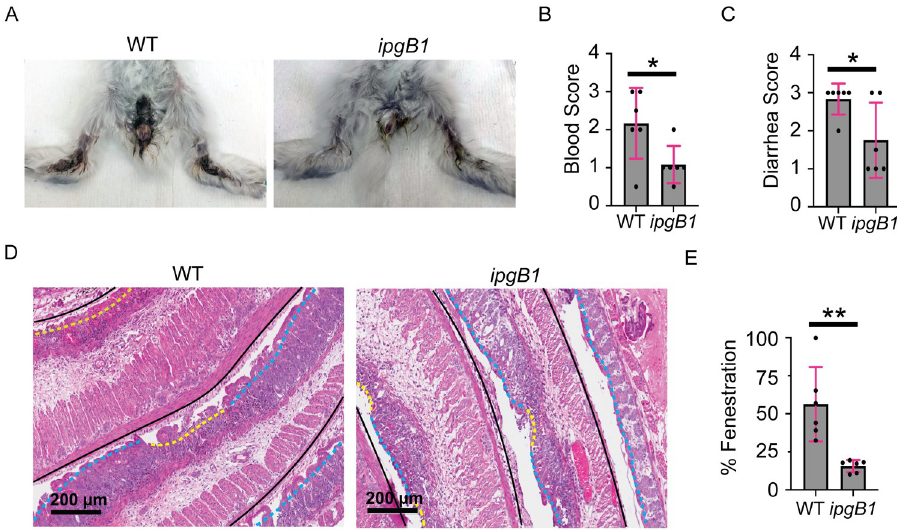
Fig 8. IpgB1 contributes to S . flexneri pathogenesis. (A) Representative images of animals infected with wild type or ipgB1 S . flexneri 24 hr postinfection. (B and C) Histopathology scores for blood in stool (B) or diarrhea (C) of animals at 24 hr postinfection with wild type or ipgB1 strains. Each dot represents one animal and grey bars show average of six biological replicates. Error bars indicate standard deviation. Unpaired two-tailed t-test; � , p < 0.05 (D) Representative images of hematoxylin- and eosin-stained colon sections from animals infected with wild type or ipgB1 at 24 hr postinfection. Black lines delineate the colon. Blue dashed lines indicate areas of intact epithelium and yellow dashed lines indicate areas with epithelial fenestration. Scale bar, 200 μ m. (E) Graph depicting the percentage of epithelial fenestration along entire colon. Each dot represents one animal and grey bars show average of six biological replicates. Error bars indicate standard deviation. Unpaired two-tailed t-test; �� , p < 0.005.